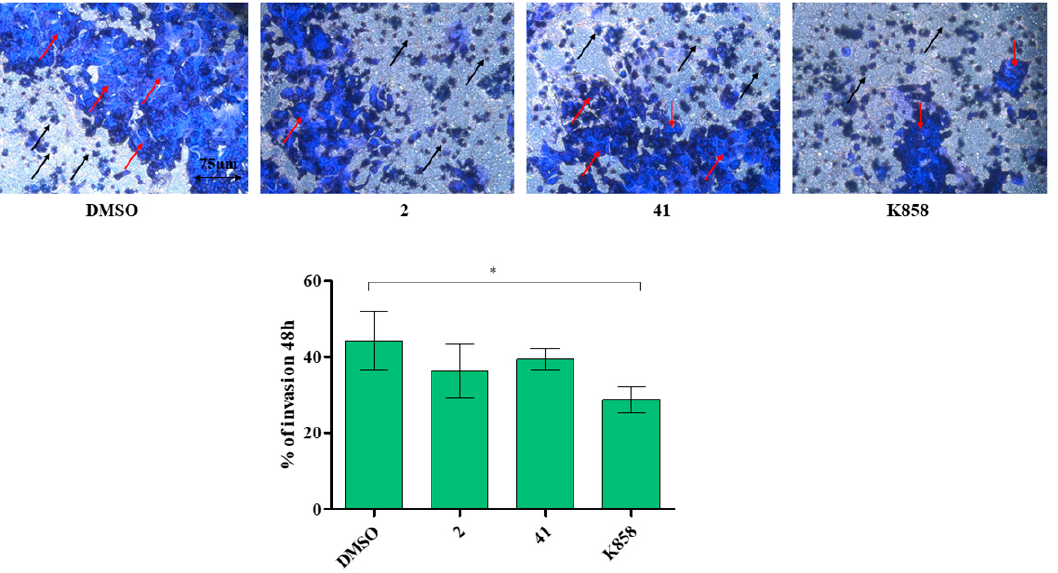
Figure 6. Transwell invasion assay of MCF7 in the presence of compounds 2 (1.5 µ M), 41 (5 µ M), and K858 (10 µ M). Images represent invading cells after crystal violet staining. Histogram represents densitometric analysis obtained by quantifying thresholded area for violet color in 10 fields for each of three slides per sample. Magnification 20 × . Dark blue represents stained invasive cells, (red arrows), light blue surface represents the insert with pores (black arrows). * p < 0.01. DMSO: control vehicle. Data are presented as mean ± SD.